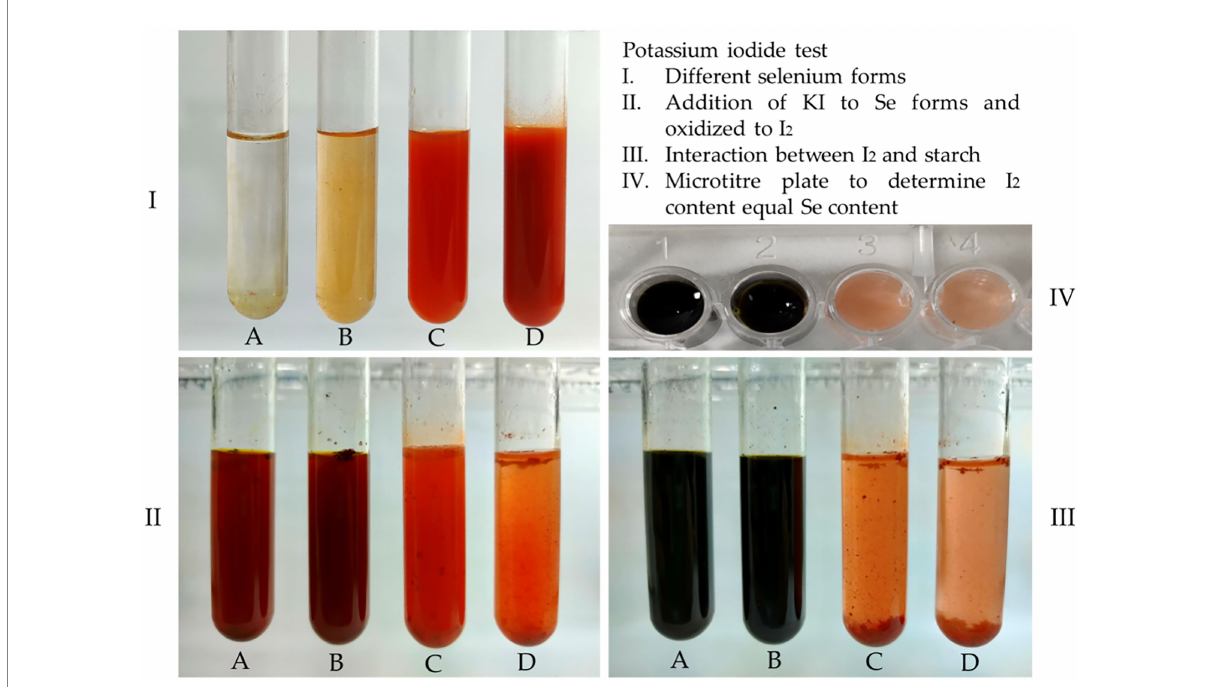
FIGURE 2 Qualitative identification of Selenium status in bio-selenium nanoparticles [BioSeNPs], obtained after 2d and 3d incubation with bacterial supernatant (C and D), as compared to two different controls:) Sodium selenite (A) and Sodium selenate (B) . I= The original selenium solutions. II= (I) + KI. III= (II) + Starch, IV= Microtiter plate to determine I 2 content equal Se